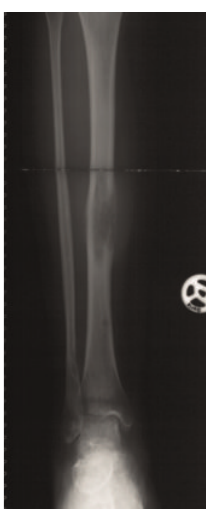
Figure 2: Preoperative AP radiograph of the right lower leg of a 23- year-old female patient with a multifocal adamantinoma of the tibia and the fibula.